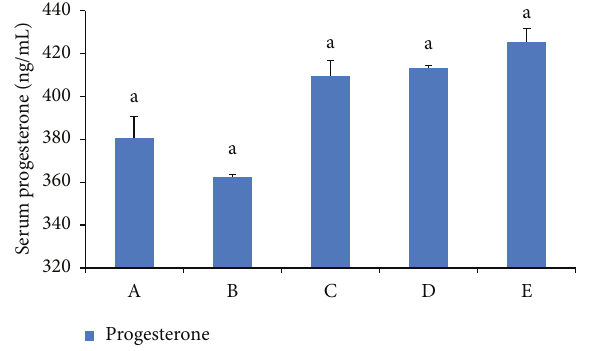
Figure 6: Progesterone in serum. Notes: (A) control group, (B) LPS group, (C) low dose of Baicalin (0.25 mg/mL), (D) middle dose of Baicalin (1.25mg/mL), and (E) high dose of Baicalin (2.5 mg/mL). Different letters mean significant at 5% level, and same letters mean no significant